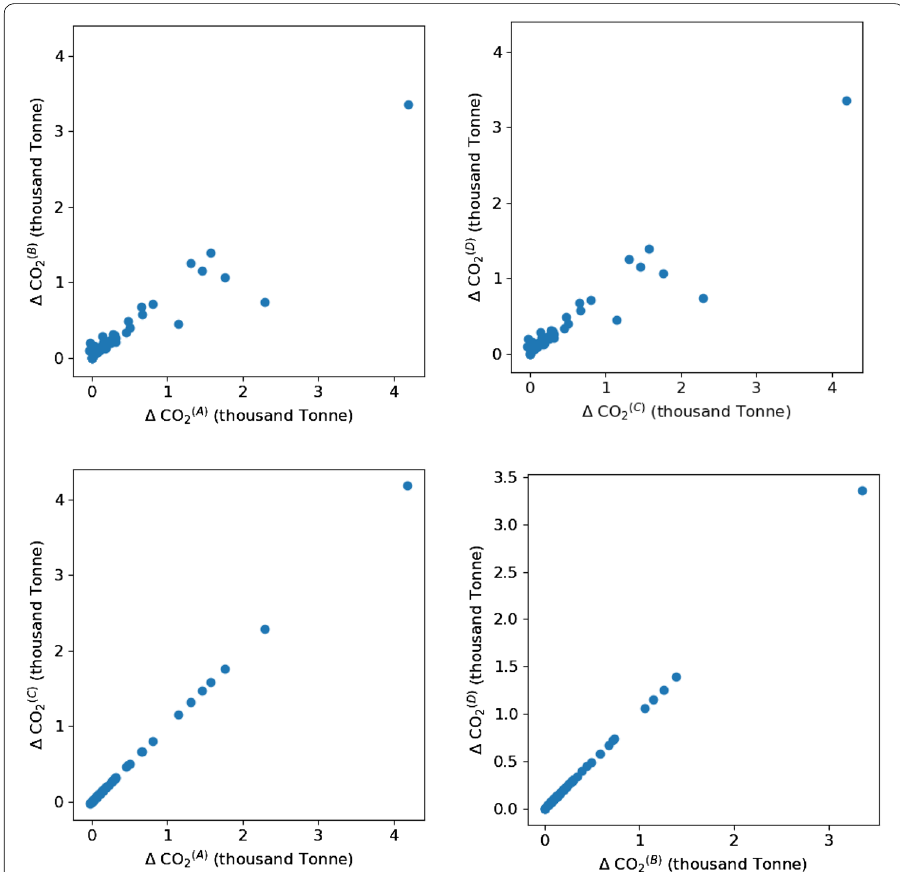
Fig. 5 Scatterplots of the change in satellite results ( (cid:31) w ) using the four models (A)–(D). Each dot represents the change in CO 2 emissions when demand for an output is increased by 1 million